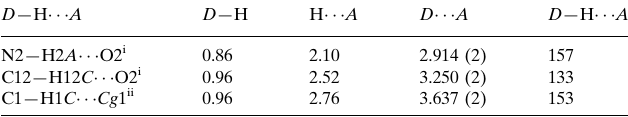
Hydrogen-bond geometry (A˚ , (cid:1) ). Cg 1 is the centroid of the C2–C7